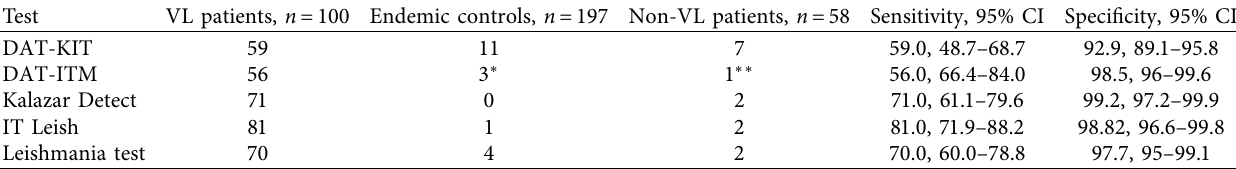
Table 1: Number of samples that tested positive and percent sensitivity and specificity of RDTs and DATs for visceral leishmaniasis. Test